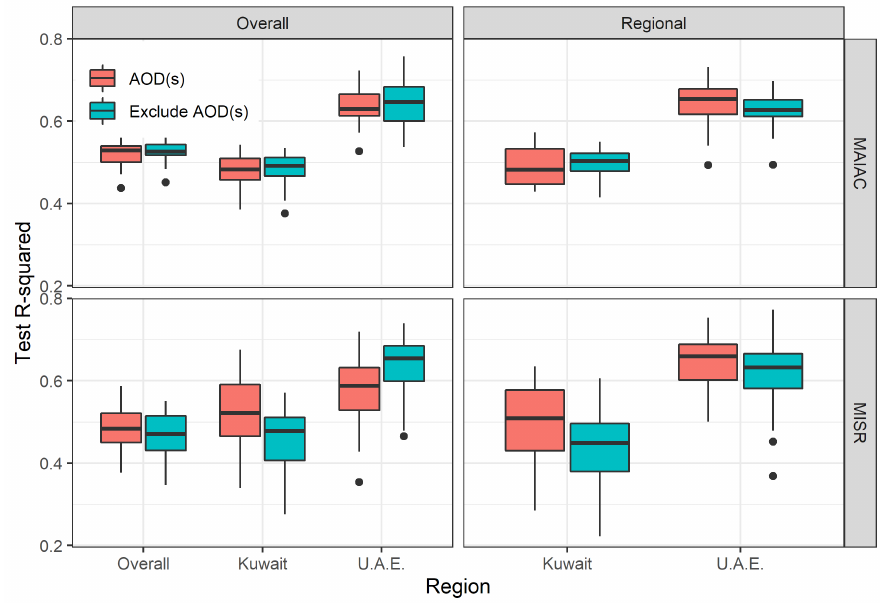
Figure 5. Test R 2 across different settings: overall and regional models, MISR and MAIAC models, and models with and without AOD variables.